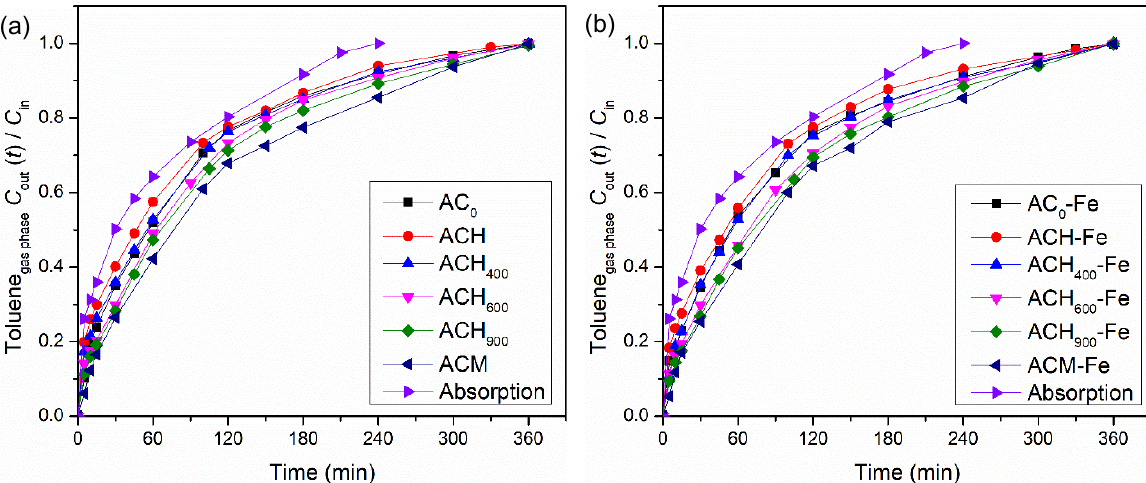
Figure 4. Toluene concentration at the outlet of the bubble reactor during absorption + adsorption experiments with modified activated carbon ( a ) and with iron-based catalysts ( b ). Experimental conditions were as follows: pH 0 = 3.0, [modified activated carbon/iron-based catalyst] = 0.75 g dm − 3 , Q air = 0.15 dm 3 min − 1 .